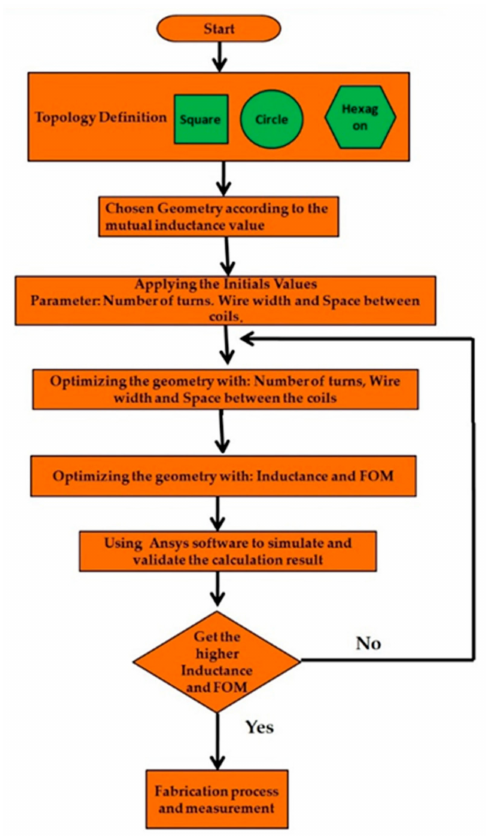
Figure 2. The stages involved in Finite Element Analysis (FEA) modelling of the proposed